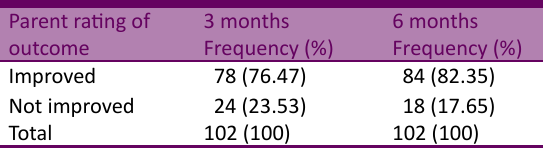
Table 4 – Overall outcome of interventions at 3 months and 6 months based on parental